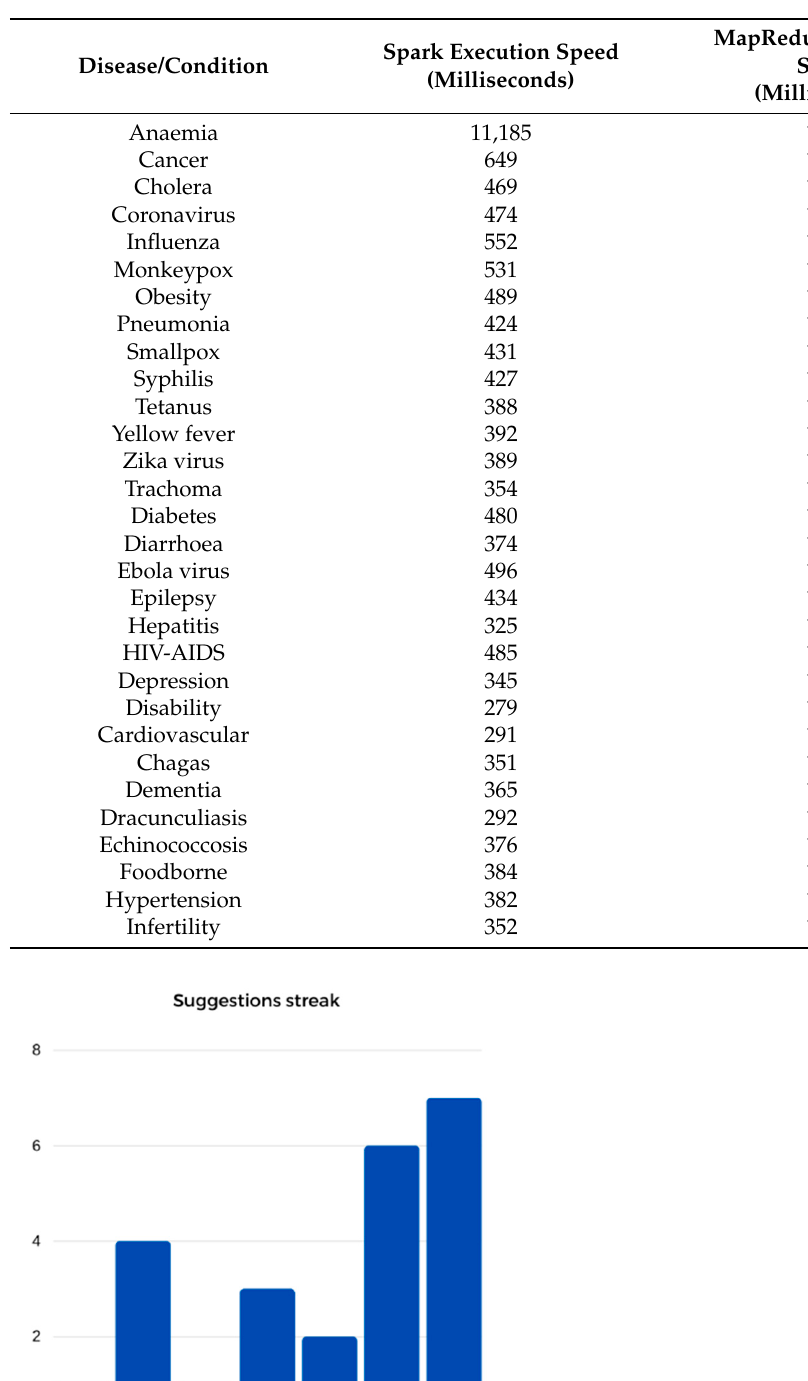
Table 6. Processing Execution Speeds.